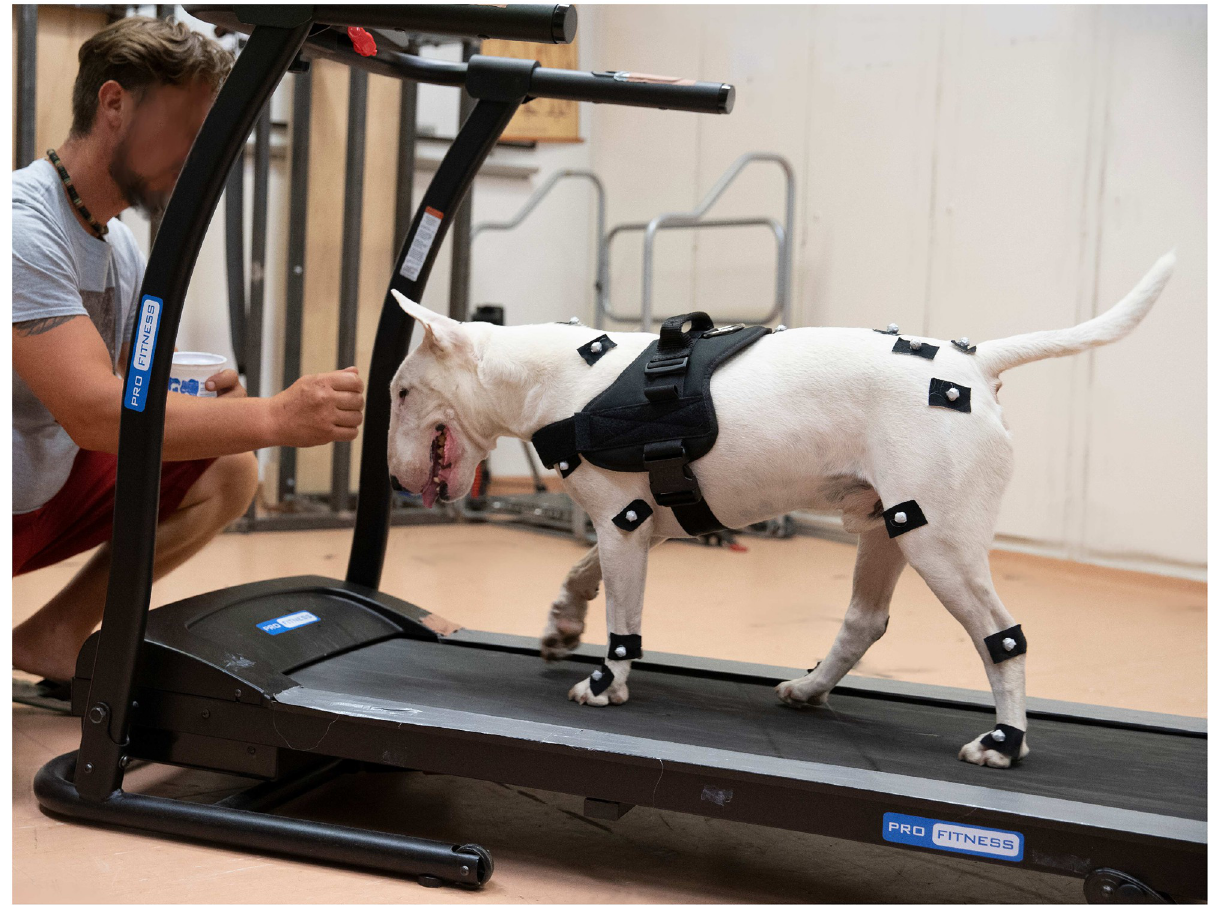
Fig 1. Measurement